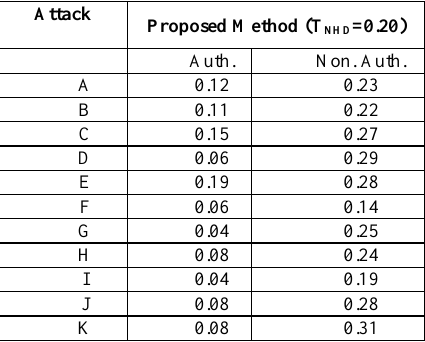
Table 7. NHD for Proposed Method.